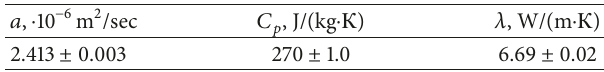
Table 5: The result of uranium dioxide sample